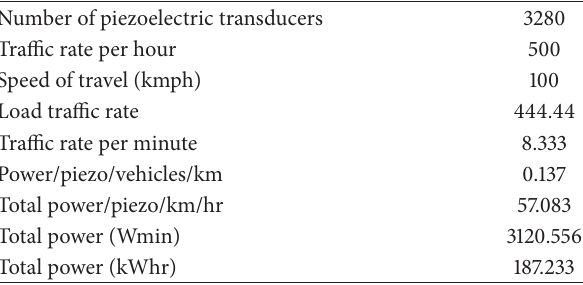
Table 3: Power estimation from one-kilometer stretch road.